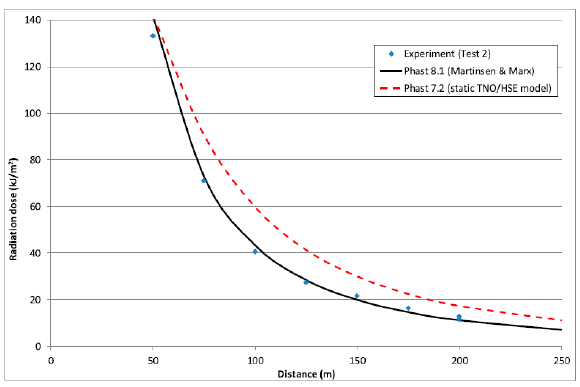
Figure 6. Radiation dose predictions for butane fireball experiment